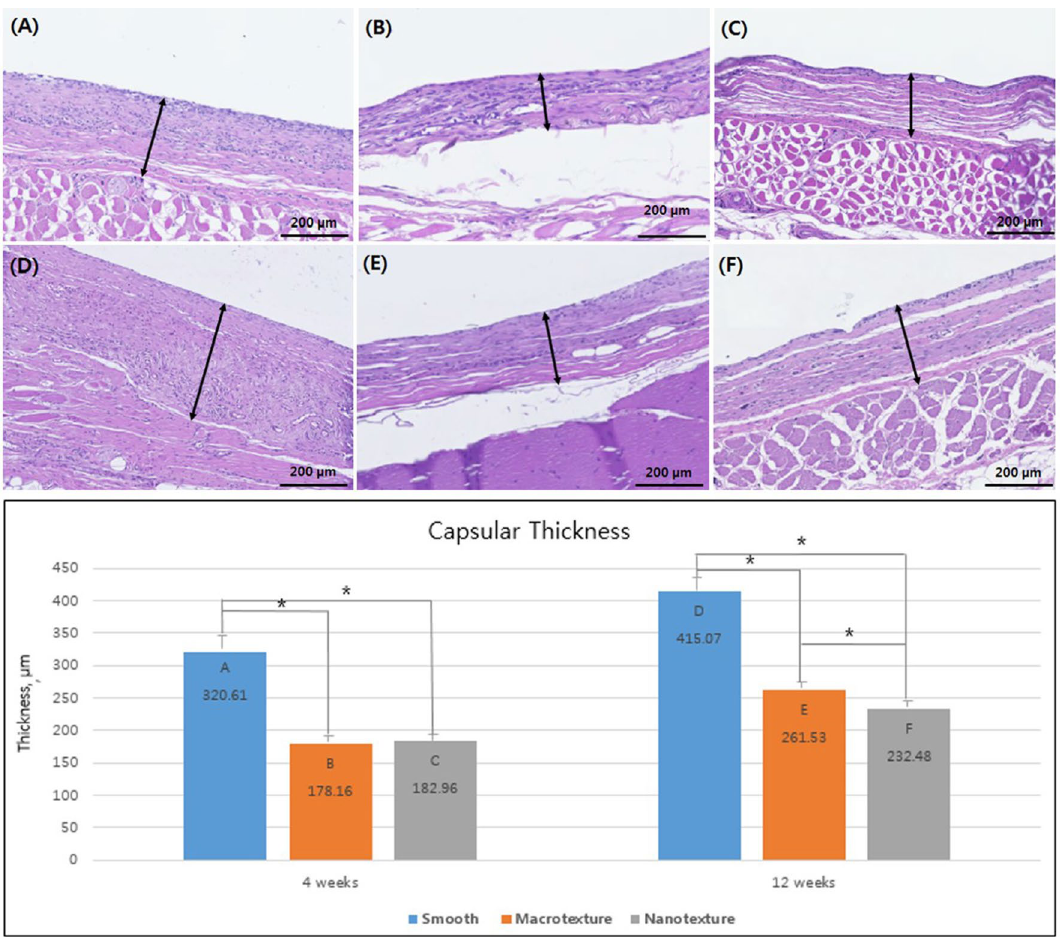
Figure 2. Capsule formation of the three different types of silicone implants. Representative histologic sections of capsular tissues on the silicone implants showing capsular thickness (original magnification, × 100; scale bar = 200 μm). Sections were stained with hematoxylin and eosin. The bar graph shows the thickness of capsule. The black asterisks in the bars represent P values indicating significant differences between the groups ( P < 0.05). ( A ) Group A (4 weeks, smooth type), ( B ) Group B (4 weeks, macrotexture type), ( C ) Group C (4 weeks, nanotexture type), ( D ) Group D (12 weeks, smooth type), ( E ) Group E (12 weeks, macrotexture type), ( F ) Group F (12 weeks, nanotexture